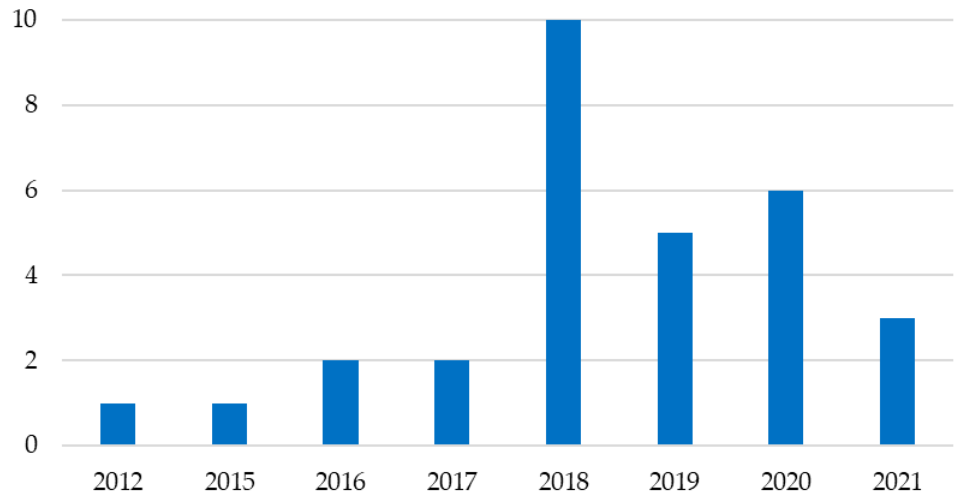
Figure 4. Yearly distribution of the included articles.